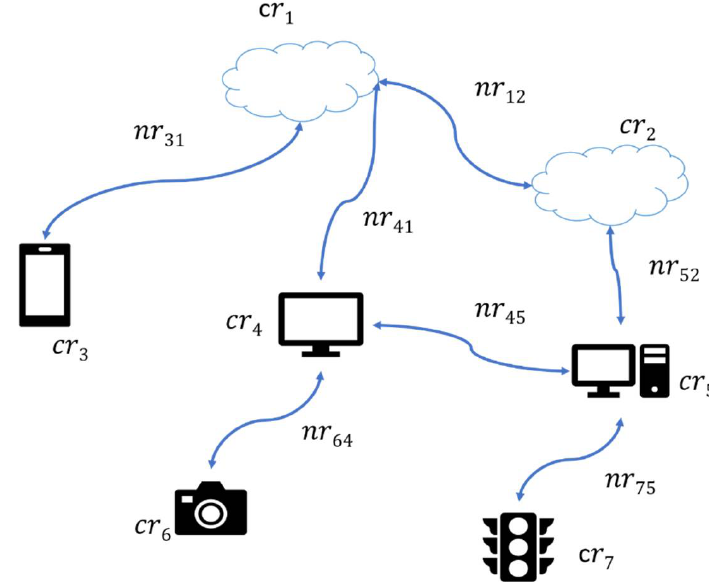
Figure 2. IoT environment graph.